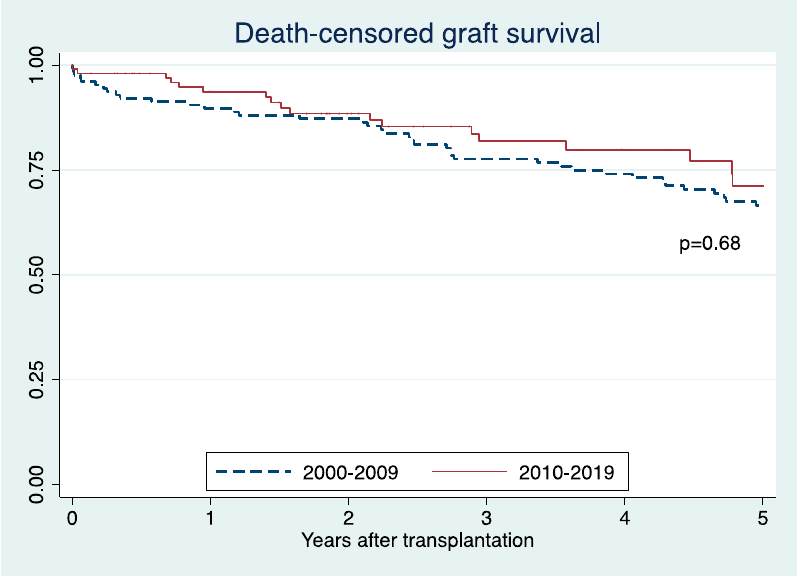
Figure 5. Death-censored graft survival of sickle cell disease recipients in 2010–2019 and 2000–2009.